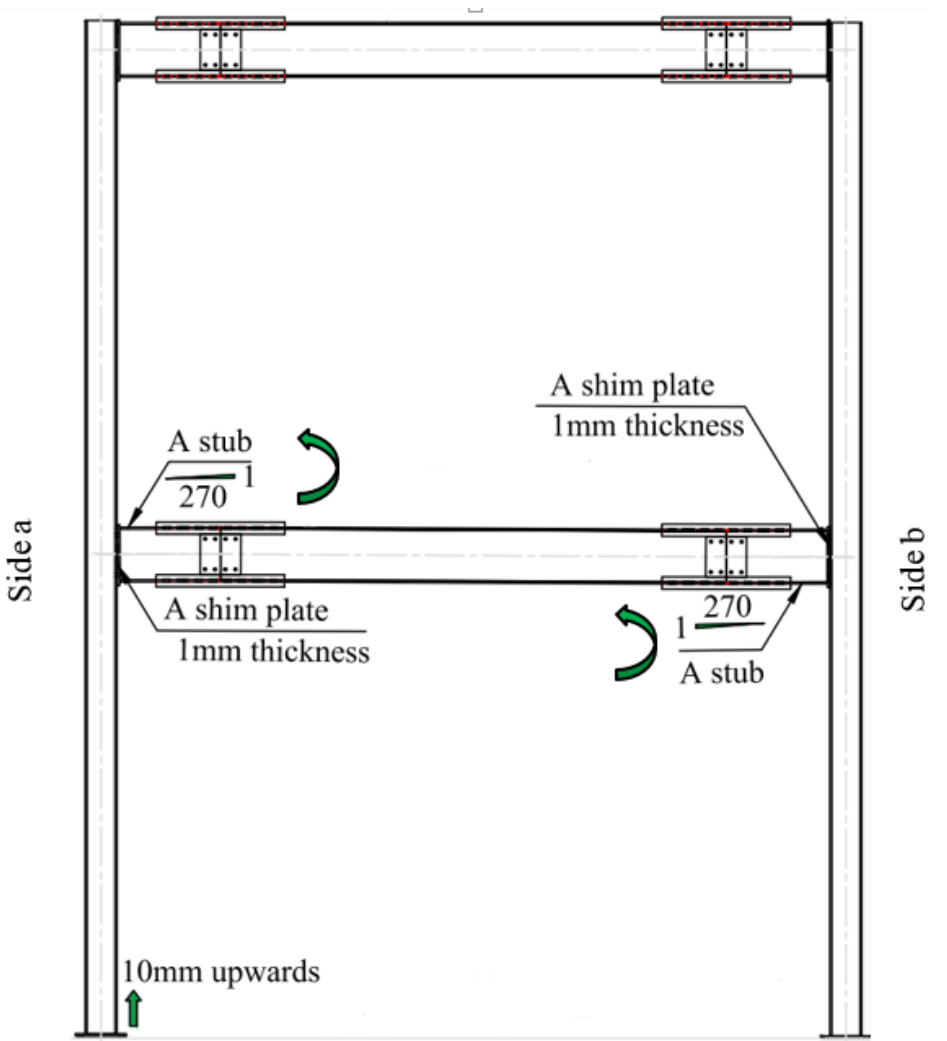
Figure 21. E ff ects of all the introduced Figure 21. Effects of all the introduced deviations.